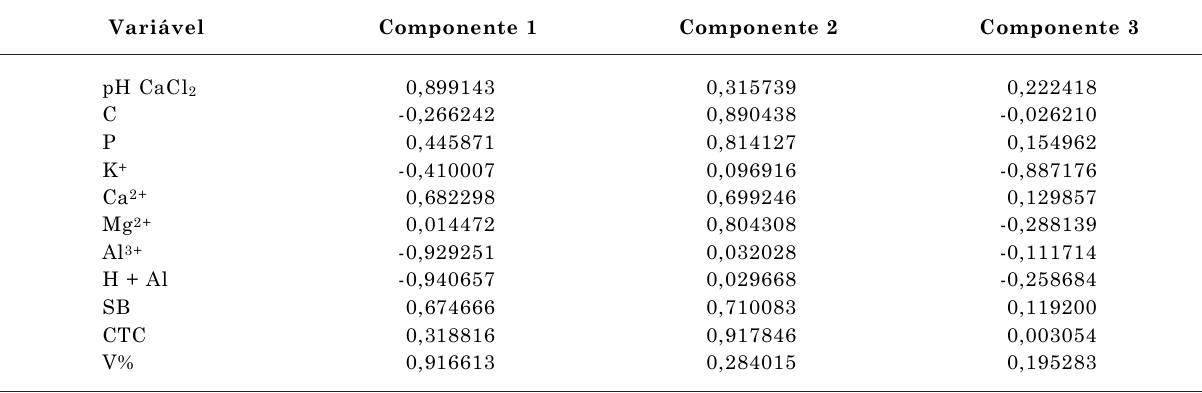
Quadro 6. Coeficientes associados a cada variável de fertilidade do solo durante a definição dos componentes principais, após rotação pela variância máxima